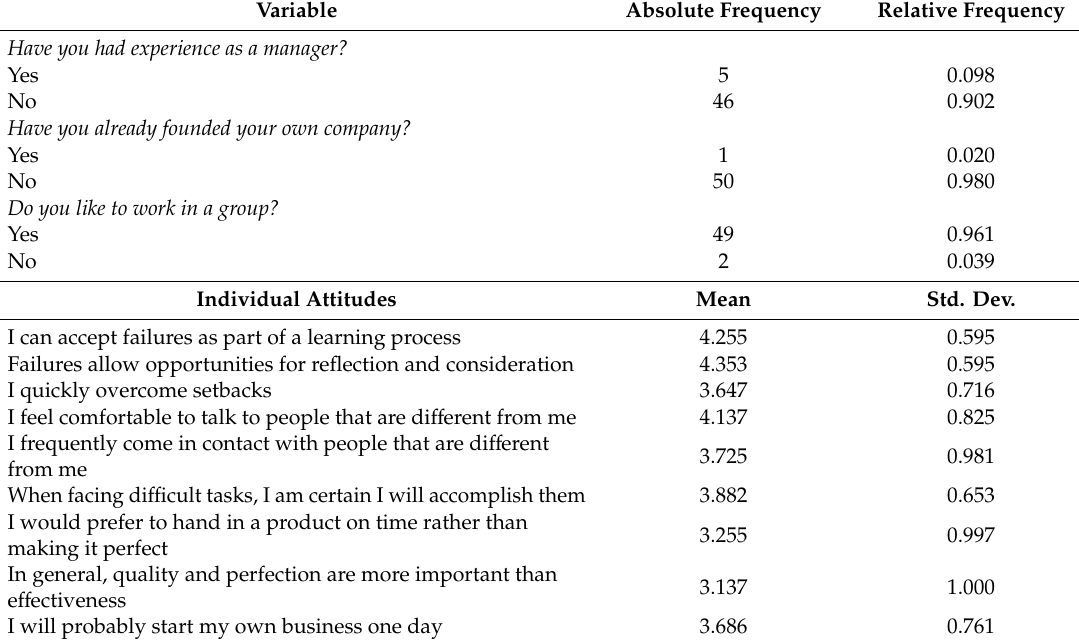
Table 1. Sample characteristics of the survey (phase